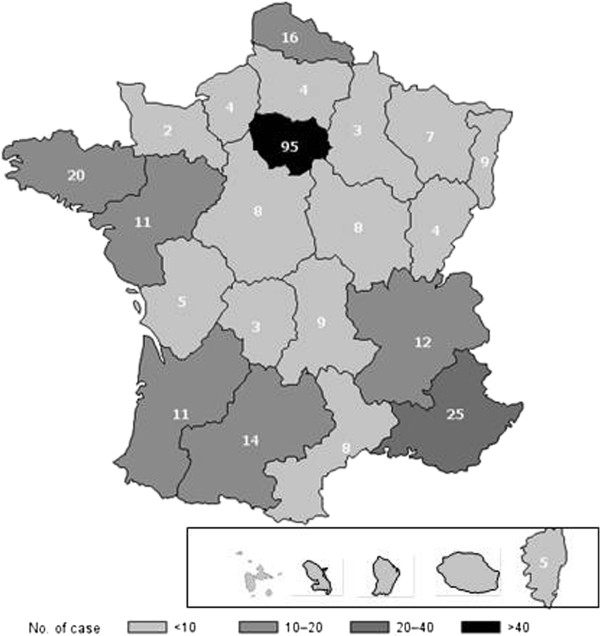
Map showing the locations of the hospitals monitoring the 283 patients with recent follow-up (2009–2010).